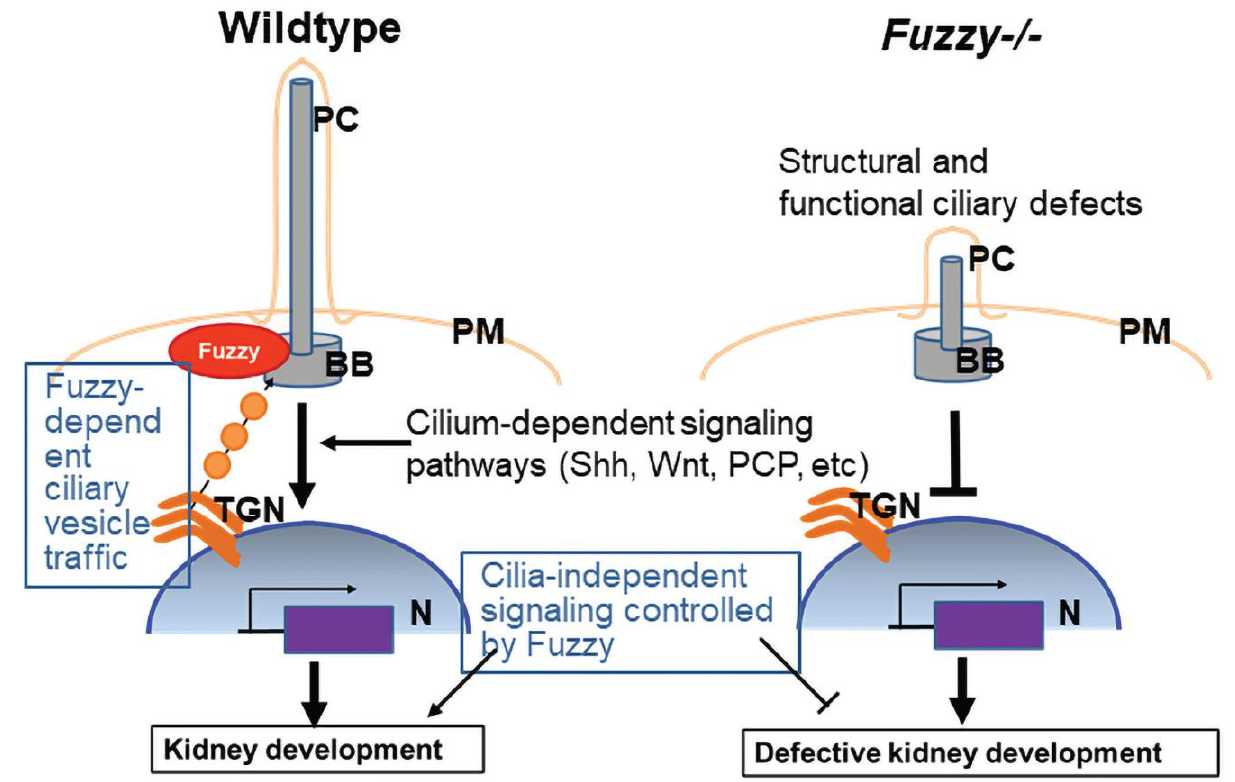
Figure 8. Model of Fuzzy involvement in kidney development. In the wildtype cells, Fuzzy-dependent vesicle trafficking that originates in Trans-Golgi Network (TGN) delivers cargo proteins necessary for structural and functional integrity of the primary cilium (PC) to the basal body (BB). Functional primary cilium controls multiple signaling pathways that may act via transcriptional regulation of downstream targets in the nucleus (N). Kidney development relies on timely localized expression of multiple transcription and growth factors; expression of some of these molecules is controlled by cilium-dependent signaling events. Potentially, Fuzzy could also control processes that do not rely on the primary cilium or transcriptional regulation (e.g., stabilization of cell projections necessary for directional cell movements). When Fuzzy is lost, all Fuzzy-dependent processes are deregulated, leading to defective kidney development.